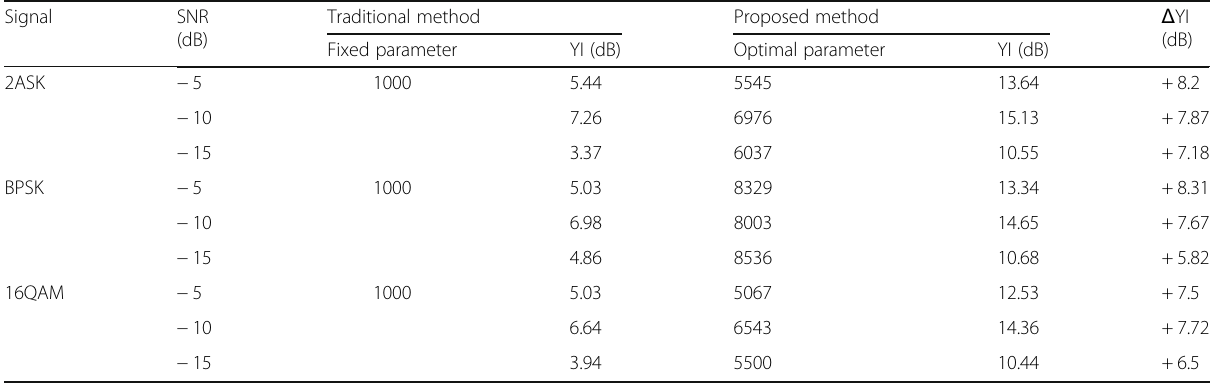
Table 2 Contrast experiment results